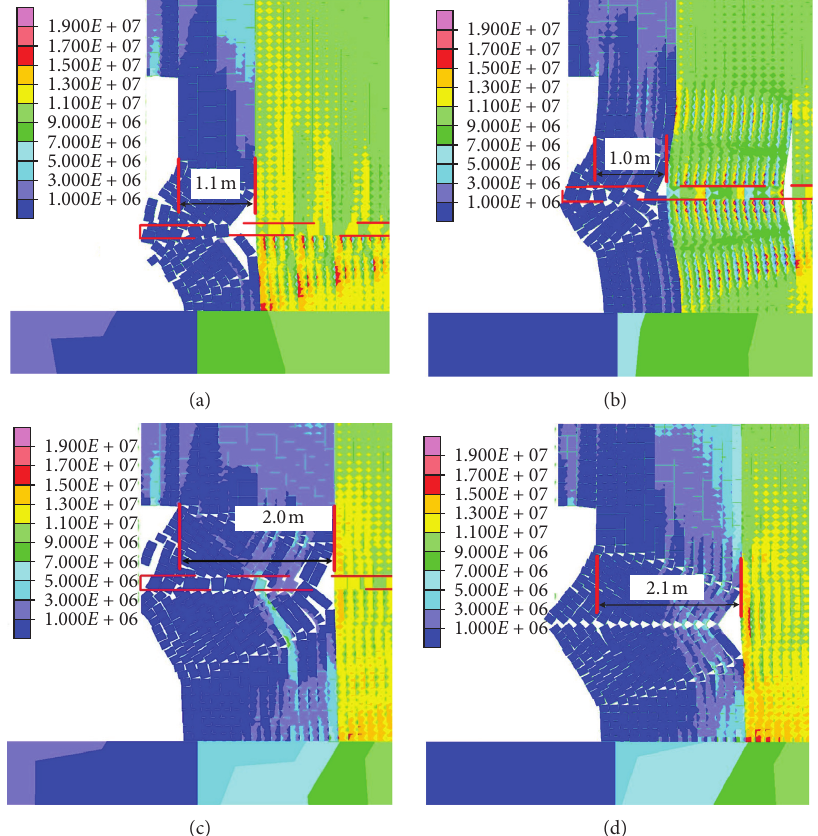
Figure 4: Cloud chart of vertical stress distribution in coal seam (Pa): (a) lower gangue; (b) middle gangue; (c) upper gangue; (d) without